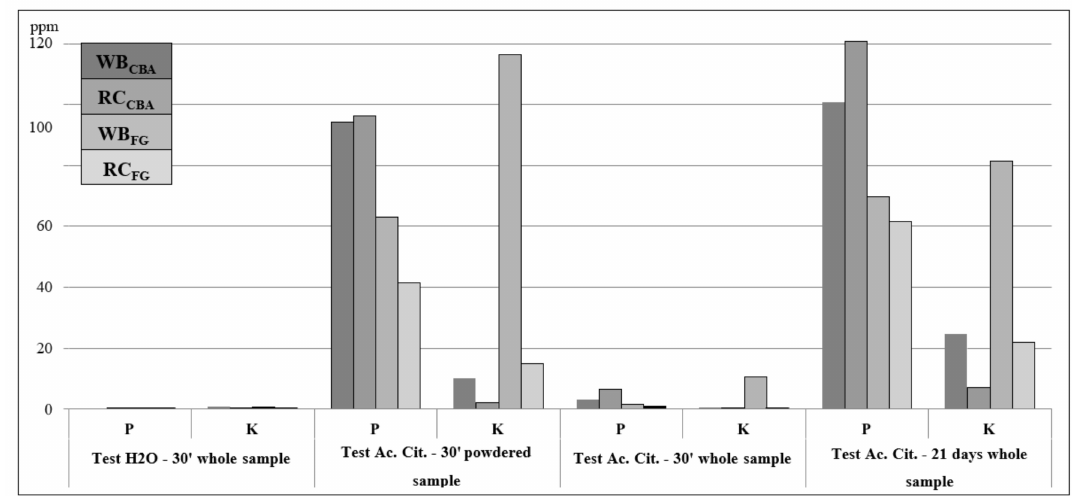
Figure 7. LWA leaching test results (ppm) in water (H 2 O) 30 min for whole samples (WS) and 30 min and 21 days in citric acid (C 6 H 8 O 7 ) for whole and powdered samples